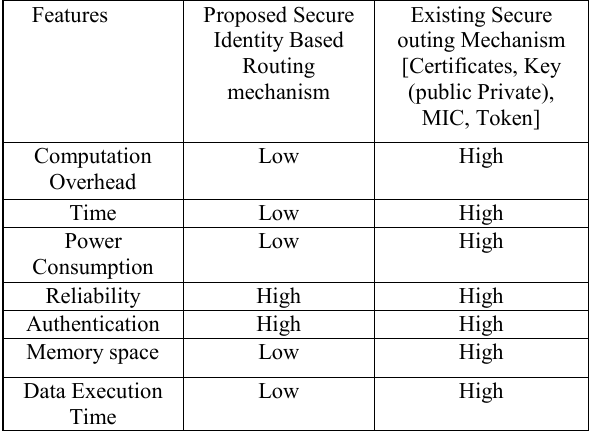
Table1. The differences between Existing and proposed